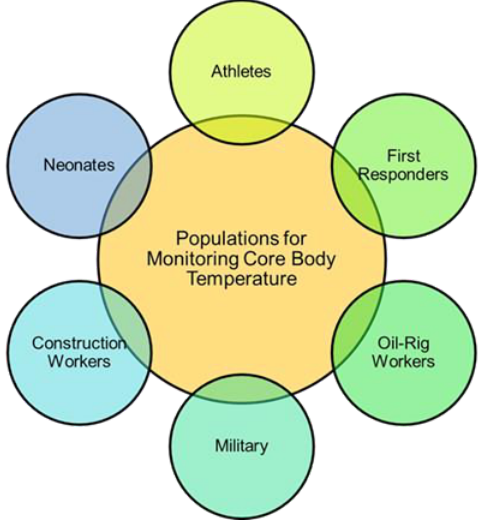
Figure 1. Populations at a high risk for HRI and, thus, most important for the monitoring of CBT. This review focuses on the monitoring of CBT in athletes and other patients in dynamic environments such as first responders, oil rig and construction workers, and military, as solutions already exist for inpatient and neonate monitoring.